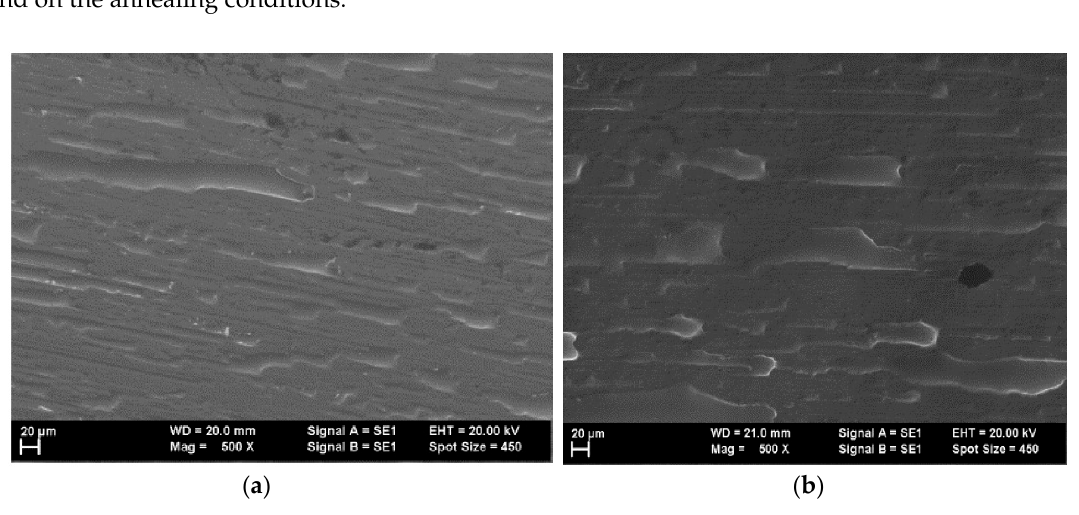
Figure 2. ( a ) SEM image of the Co 48 Pt 28 Ag 6 B 18 as cast sample; ( b ) SEM image of the Co 48 Pt 28 Ag 6 B 18 sample, annealed at 670 °C for 1